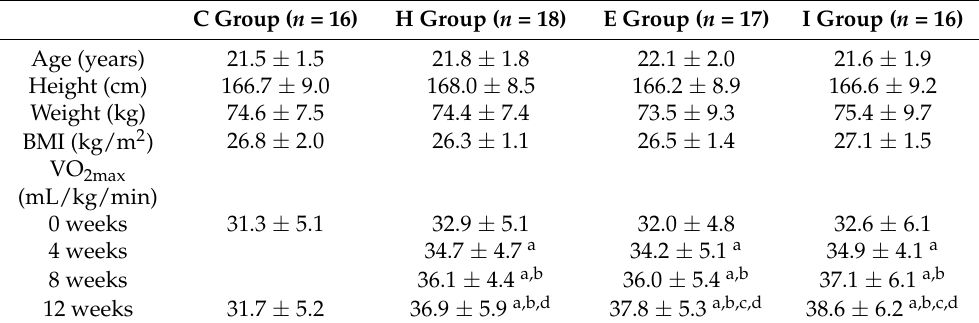
Table 1. Physical characteristics of the participants and the changes in VO 2max .